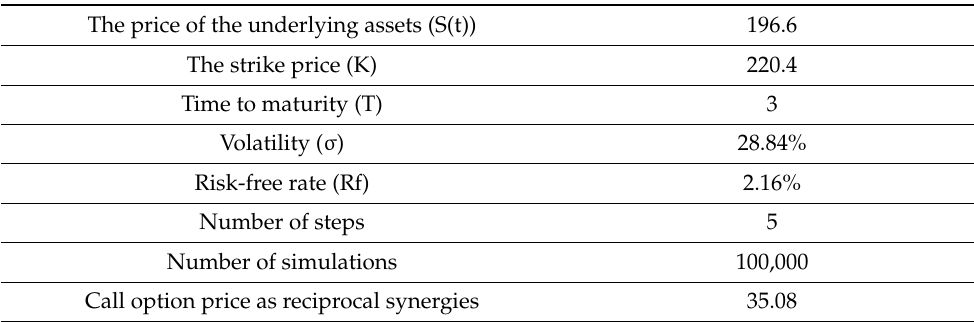
Table 7. Parameters of the Monto Carlo simulations and the value of synergies: European call option value (Samsung’s acquisition of Harman, in US$ bn).